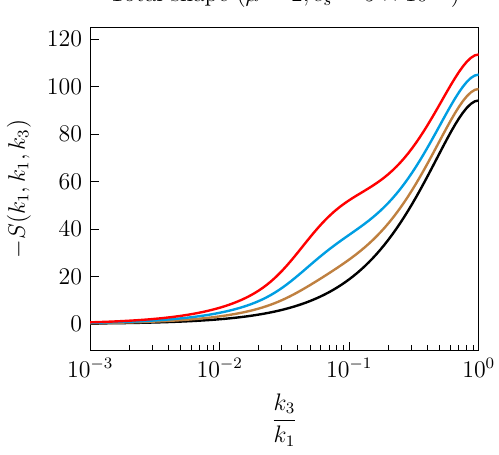
Figure 14 . Shape S ( k 1 , k 1 , k 3 ) of the total bispectrum for isosceles triangles, found by adding the effects from the self-interactions in ˙ π ( ∂ ) 2 and the effect of Diagram B2 (see the main text), for i π c s = 0 . 05 , µ = 2 and ρ/m = (0 , 2 , 3 , 4) (black, brown, blue,